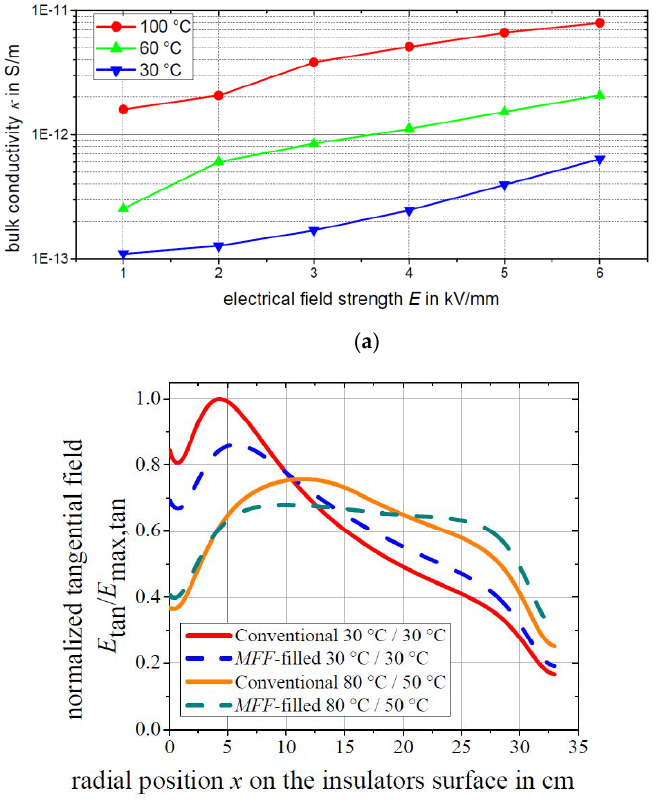
Figure 8. Graphs of the electric conductivity of MFF filled epoxy and the resulting electric field distribution along the insulator’s surface. ( a ) Measured bulk conductivity at three di ff erent temperatures (30 ◦ C, 60 ◦ C and 100 ◦ C). ( b ) Normalized tangential electric field distribution E tang at the insulator’s surface made of MFF filled epoxy under 500 kV DC for constant temperature (30 ◦ C) and gradient temperature compared to conventional epoxy material σ (30 ◦ C) = 10 − 13 S / m